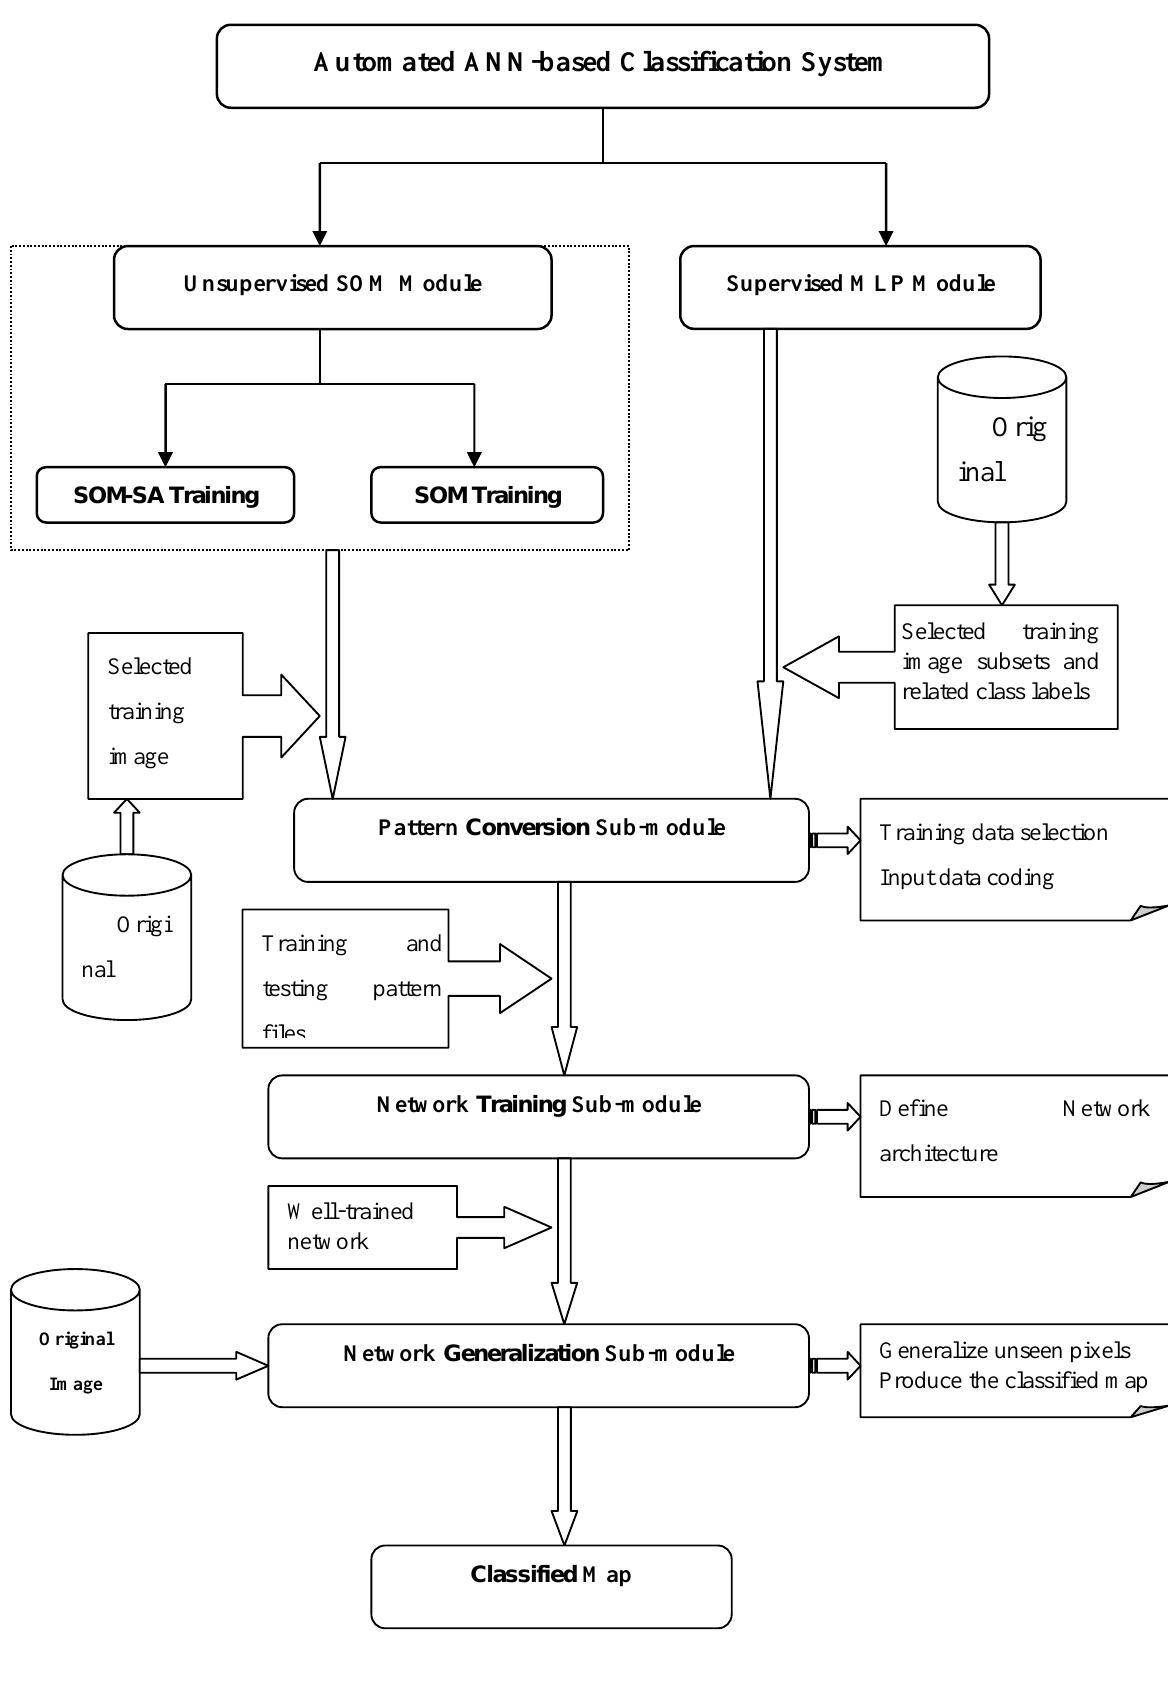
Figure 3. Flowchart of the ANN-based classification